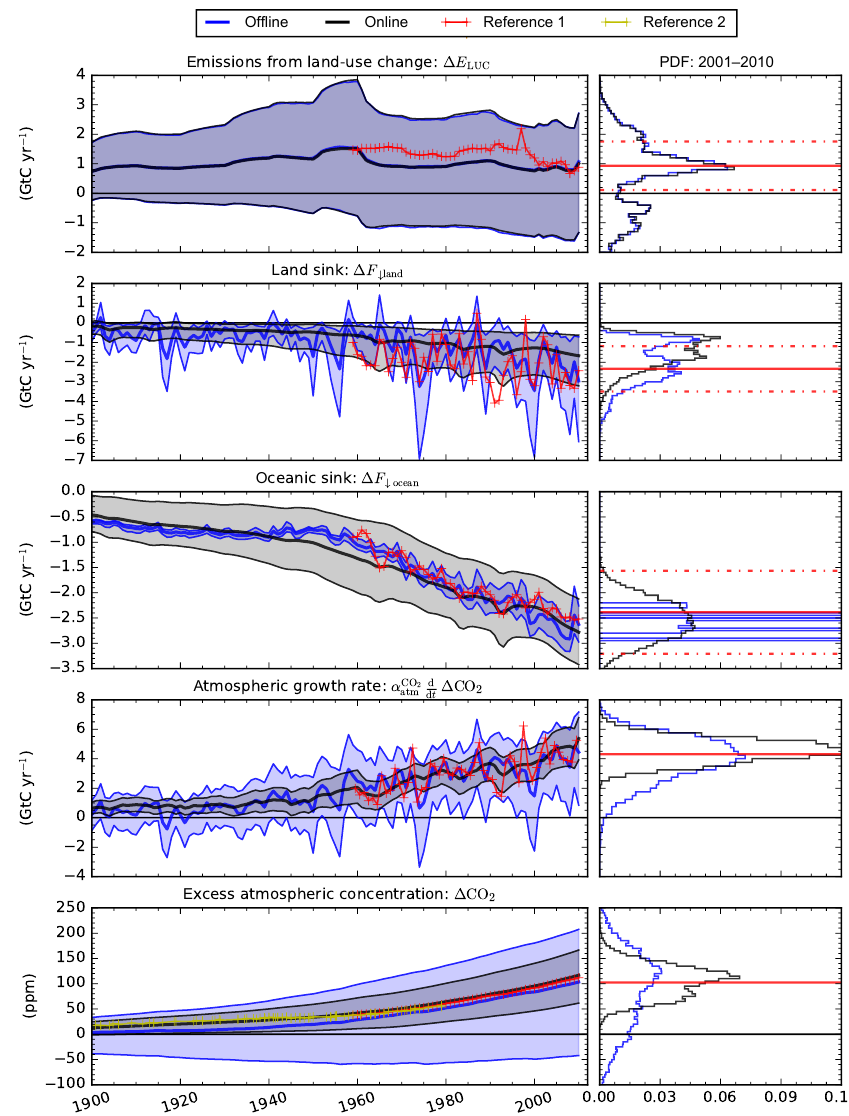
Figure 5. Results of our simulations with OSCAR, for carbon dioxide. The offline simulation is shown in blue, and the online simulation in black. Other colors are references we compare our results to. The left-hand panels show the time series from 1900 to 2010, the thick colored lines indicate the median of the ensemble of simulations, and the colored area its 5th to 95th percentiles. The right-hand panels show the probability distribution function (PDF) from the ensemble of simulations, for the averaged last 10 years of simulation. Reference for the first three fluxes is the GCP (Le Quéré et al., 2015), and the dashed red lines show the 90% uncertainty range (calculated as 1.645 times the 1 σ -uncertainty). Reference 1 for the atmospheric growth rate and concentration is NOAA/ESRL (Tans and Keeling, 2015). Reference 2 denotes Law Dome ice cores (Etheridge et al., 1996; MacFarling Meure et al.,